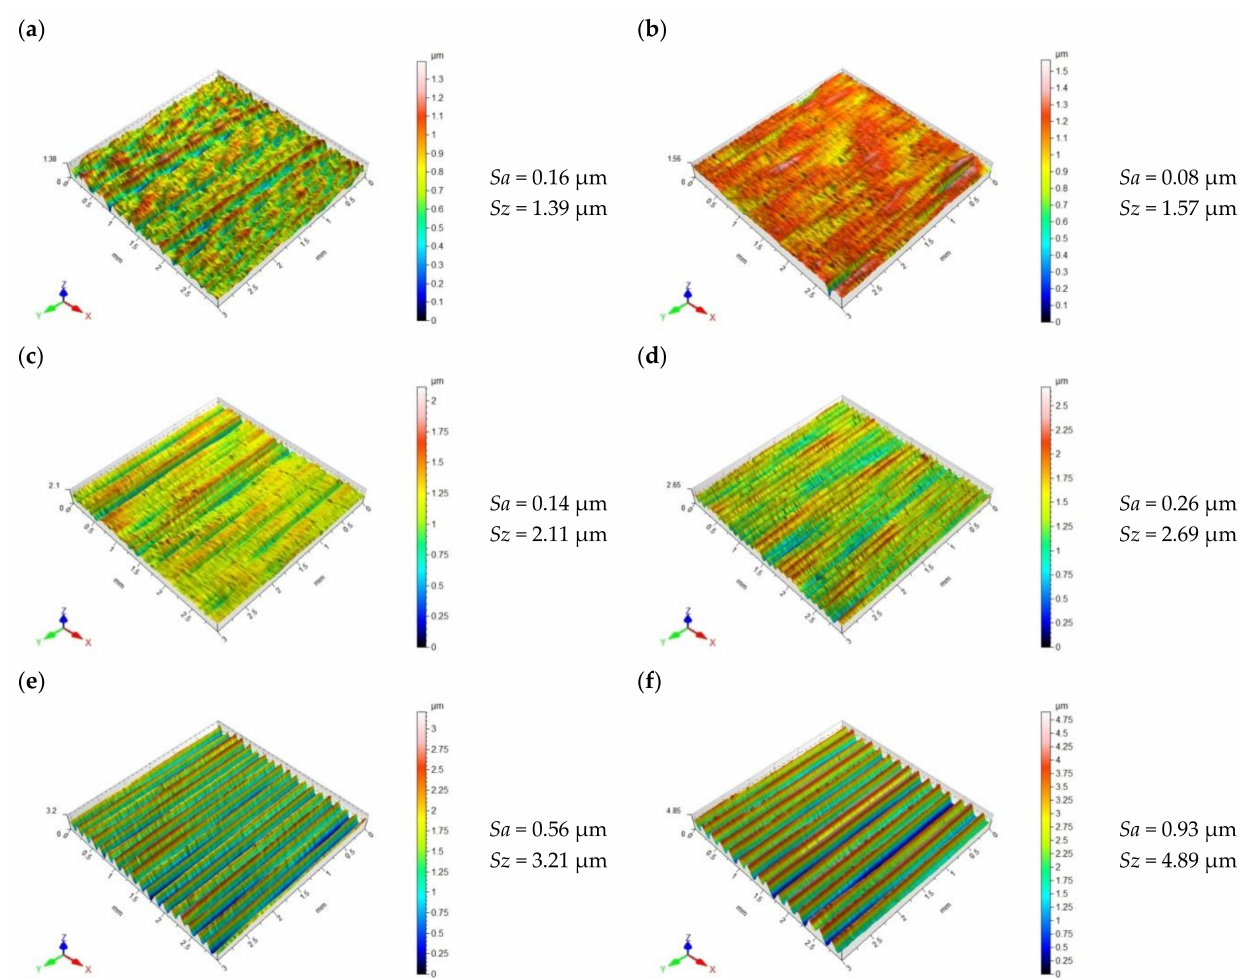
Figure 6. Topography of X6CrNiTi18 steel surface after slide burnishing: ( a ) f = 0.03 mm/rev., F = 230 N; ( b ) f = 0.06 mm/rev., F = 230 N; ( c ) f = 0.09 mm/rev., F = 230 N; ( d ) f = 0.12 mm/rev., F = 230 N; ( e ) f = 0.16 mm/rev., F = 230 N; ( f ) f = 0.20 mm/rev., F = 230 N.